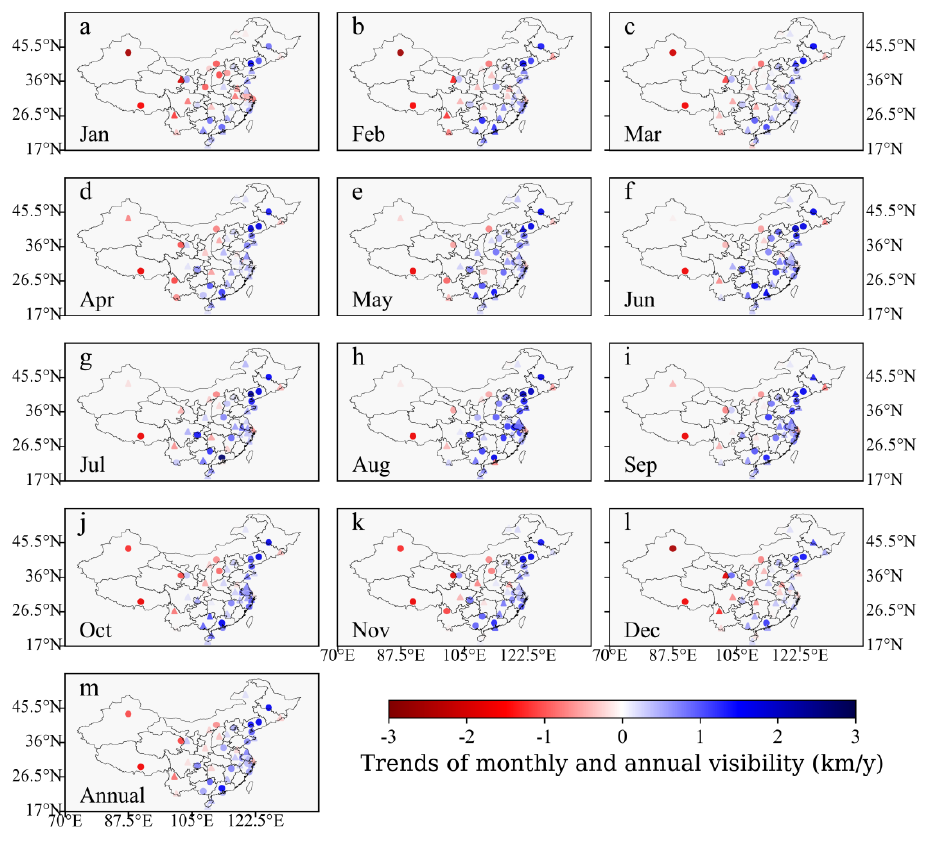
Figure 4. Spatial distributions of the trends of monthly and annual visibility during 2010–2020. Triangles represent statistically significant trends ( p < 0.05).